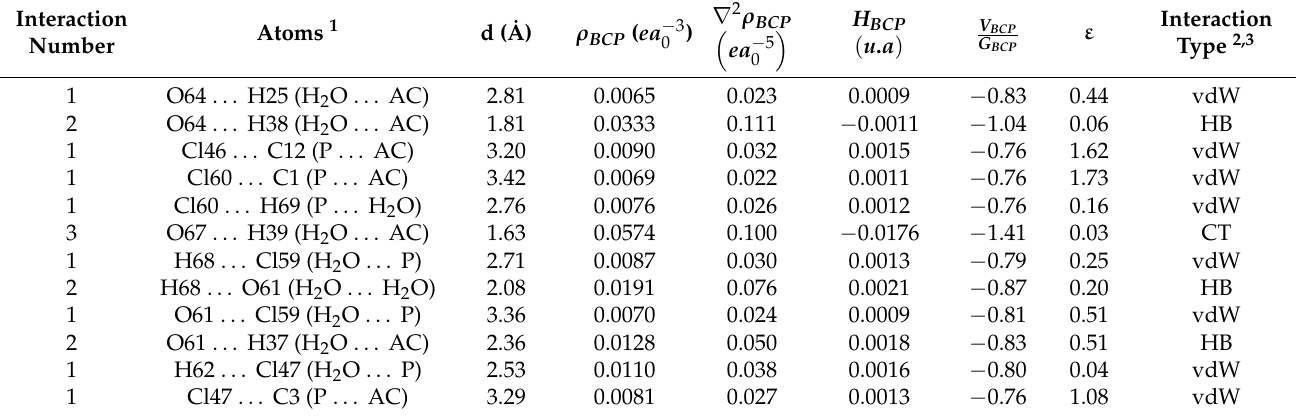
Table 2. Interatomic distances (d), electron density ( ρ BCP ), Laplacian of electron density ( ∇ 2 ρ BCP ), total energy density ( H BCP ), potential-kinetic energy density ratio ( V BCP / G BCP ), and ellipticity of the electron density ( ε ) at the bond critical points (BCPs) for the system NH 3+ /CLD/(H 2 O) 3